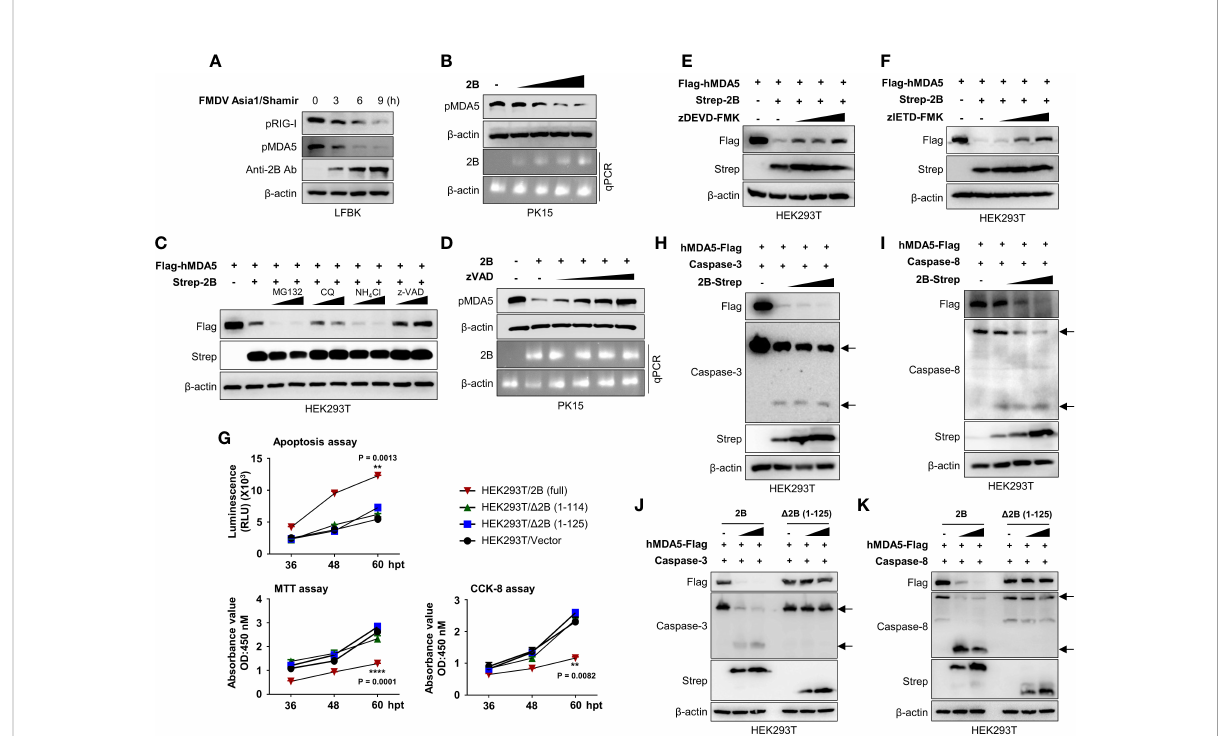
FIGURE 6 FMDV 2B induces apoptosis and apoptosis-mediated caspase-3 and caspase-8 dependent degradation of MDA5. LFBK cells were infected with 0.1MOI of FMDV Asia1/Shamir for 0, 3, 6, 9 hours and whole-cell lysates were immunoblotted with indicated antibodies (A) . PK-15 cells were transfected with increasing doses of FMDV 2B, and 24 hrs post-transfection cells were infected with SeV (1MOI). Cells were harvested at 24 hrs post-infection, and the MDA5 expression level was measured by immunoblotting (B) . HEK293T cells were transfected with Flag-MDA5 together with Strep-FMDV 2B and treated with two doses of MG132, chloroquine, NH 4 Cl, or zVAD for 6 hours before harvesting the cells. Whole-cell lysates were subjected to immunoblotting with indicated antibodies (C) . PK-15 cells were transfected with FMDV 2B, and 24 hrs post- transfection, cells were infected with SeV (1MOI). Cells were treated with increasing doses of zVED for 6 hours before harvesting cells. Whole- cell lysates were subjected to immunoblotting with indicated antibodies (D) . (E, F) HEK293T cells were treated with Flag-hMDA5, Strep-FMDV 2B plasmids, and treated with increasing doses of zDEVD-FMK (E) , or zIETD-FMK (F) , 6 hours before harvesting the cells. Whole-cell lysates were subjected to immunoblotting with indicated antibodies. HEK293T cells were transfected with Strep-FMDV 2B wild-type, FMDV D 2B (1-114) mutant, FMDV D 2B (1-125) mutant, and control vector. Annexin V apoptosis assay, CCK-8 assay, and MTT assay were conducted at indicated time points post-transfection (G) . (H, I) HEK293T cells were transfected with Flag-MDA5, caspase-3 (G) , or caspase-8 (H) plasmids together with increasing doses of Strep-FMDV 2B plasmids. Whole-cell lysates were subjected to immunoblotting with indicated antibodies. (J, K) HEK293T cells were transfected with Flag-MDA5, caspase-3 (J) , or caspase-8 (K) plasmids together with increasing doses of Strep-FMDV 2B wild-type